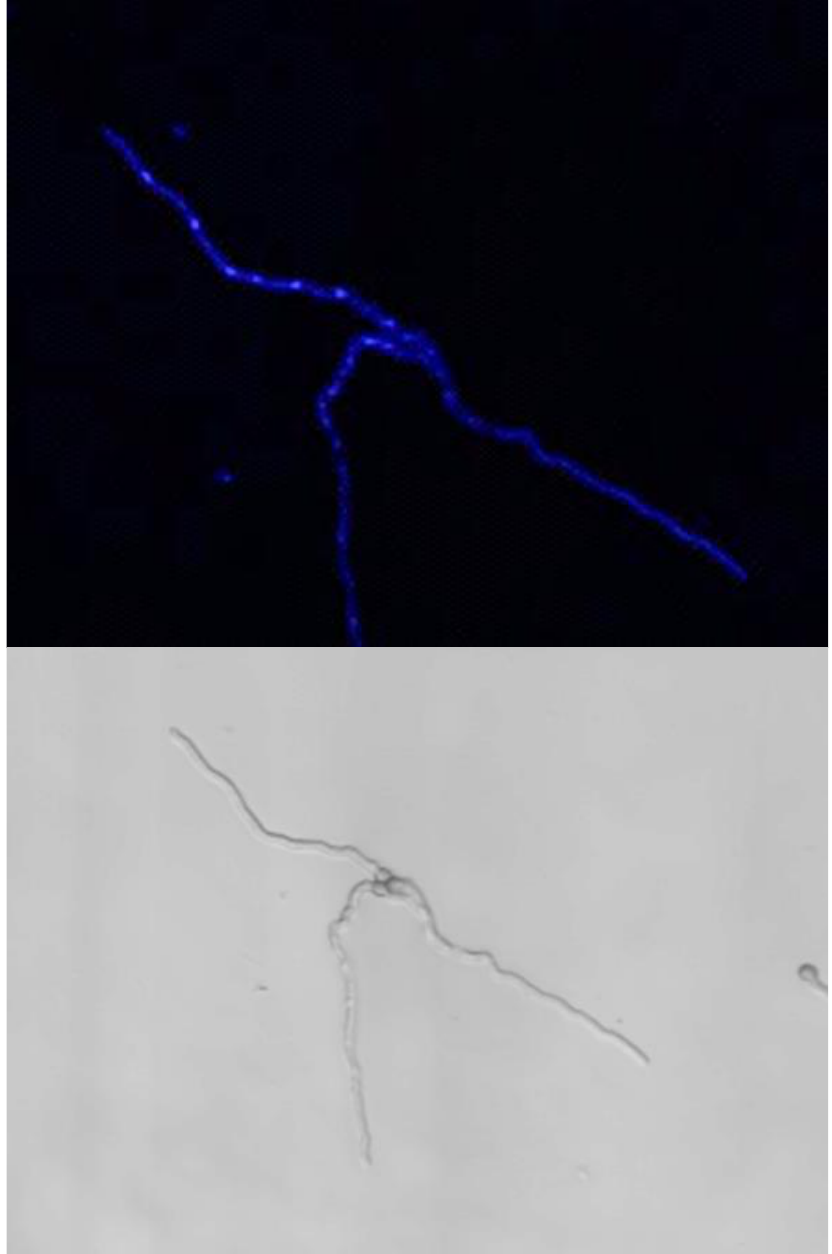
Figure 10. Stimulation of the germ tube growth by the GSK1324726A compound in the G or GA medium. The elongation of the germ tube was associated to an increase in nuclear divisions. Note the high number of nuclei per germinated conidia while in absence of drug the growth of the germ tube was stopped and contained only one nucleus per germ tube.